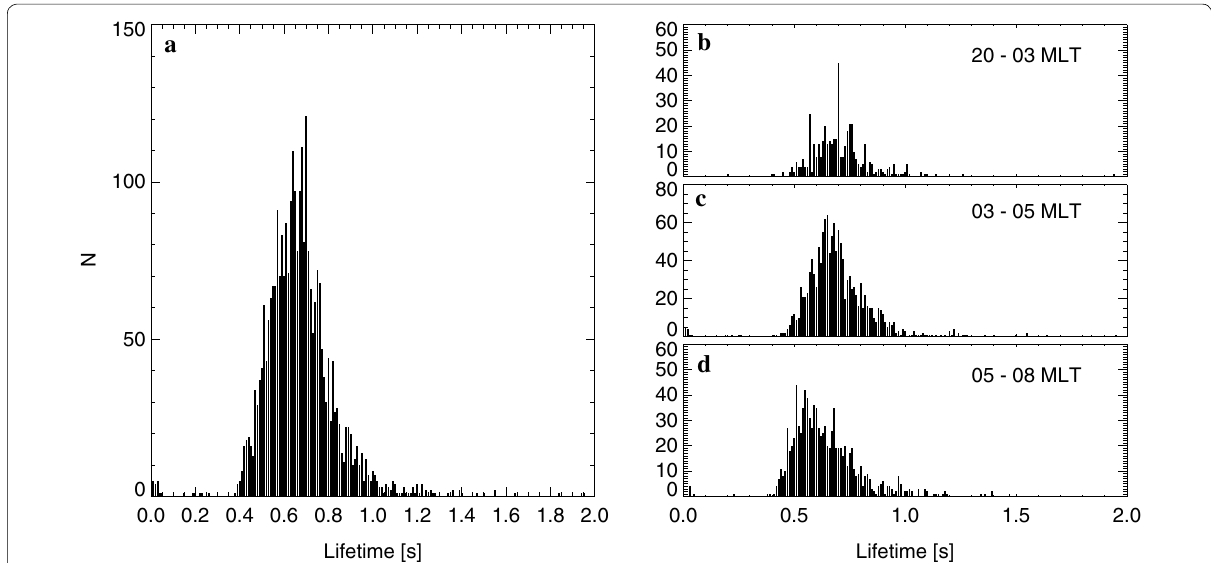
Fig. 3 a Statistical distribution of the lifetime of O( 1 S). The distributions of the lifetime for three magnetic local time sectors: b 20‑03 MLT, c 03‑05 MLT and d 05‑08